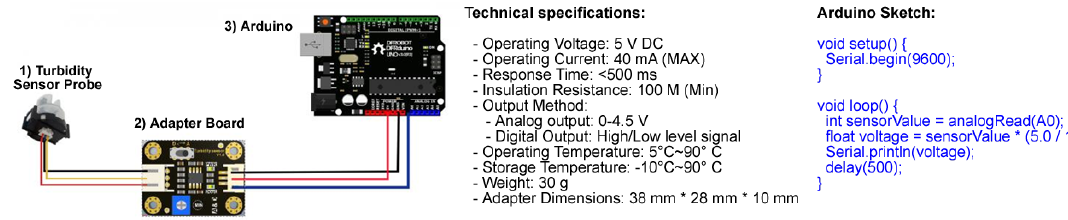
Figure 2. Wiring diagram, setup, and specifications for the DF Robot Gravity analogue turbidity sensor.